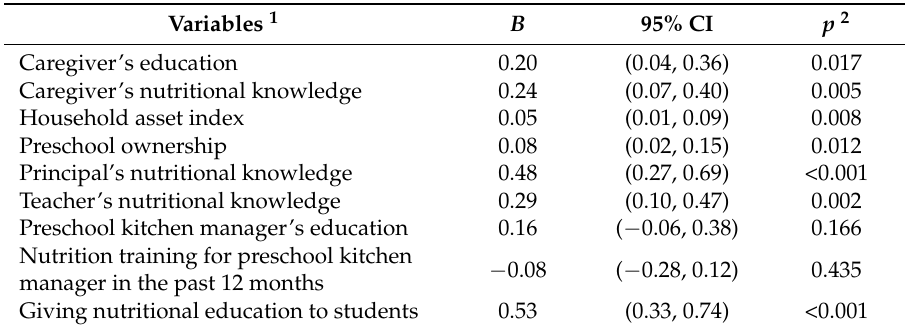
Table 5. Linear regression model of predictors of